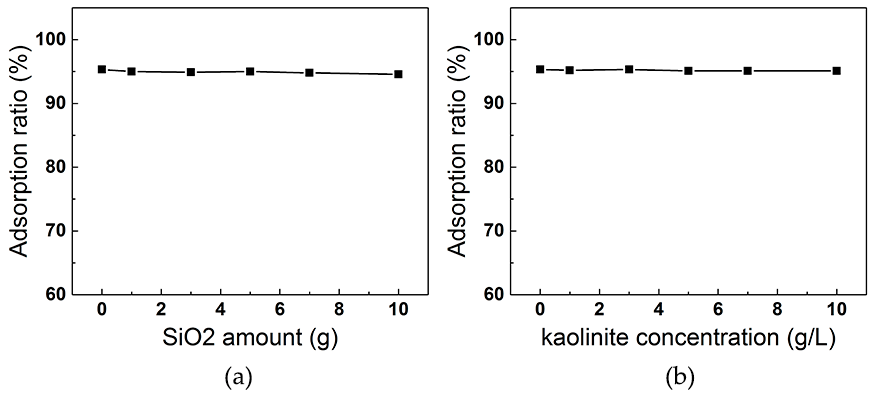
Figure 7. Effect of background chemicals ( a ) SiO 2 , ( b ) kaolinite on the adsorption of ionic liquid ([Bmim][BF 4 ]) onto ion-exchange resin (Amberlite IR 120Na).